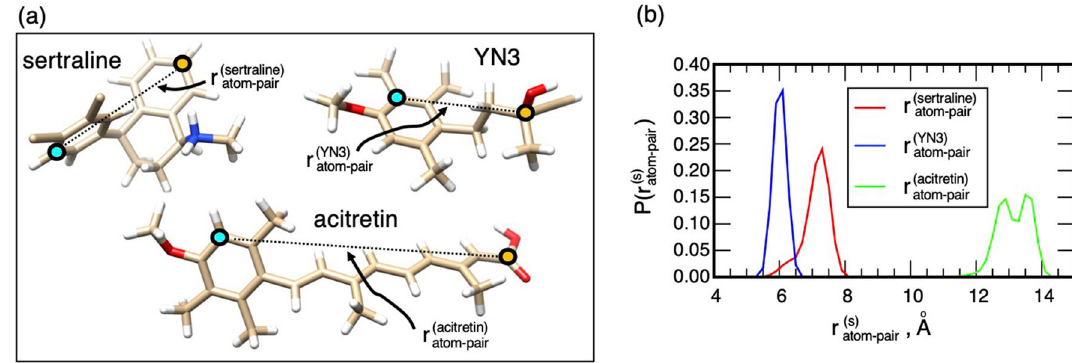
Figure 7. ( a ) Structures of the three compounds sertraline, YN3, and acitretin. For each compound, inter- ( s ) atomic distance r atom − pair ( s = sertraline, YN3, or acitretin) is defined between cyan- to orange-colored atoms. A cyan-colored atom, which is involved in a ring for each ligand, is not set on the ring rotation axis to detect the ring-rotational motions. ( b ) Distance distribution functions (DDFs), P (cid:31) r Supplementary Section 6 for procedure to calculate